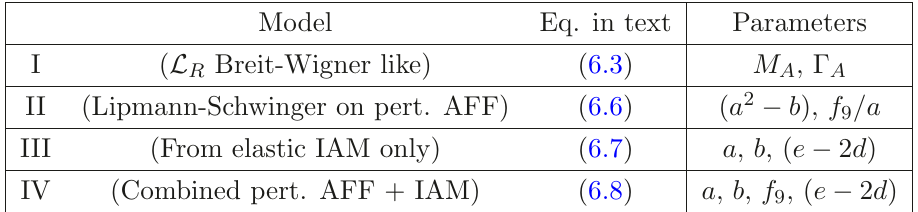
Figure 5 . The I = J = 1 axial form factor in V L h . Here we compare various models of the form factor for fixed values of the chiral parameters. Because the resonance is relatively narrow, the form factor is controlled by its physical mass and width parameters, so the model differences are small (at the level of a percent).